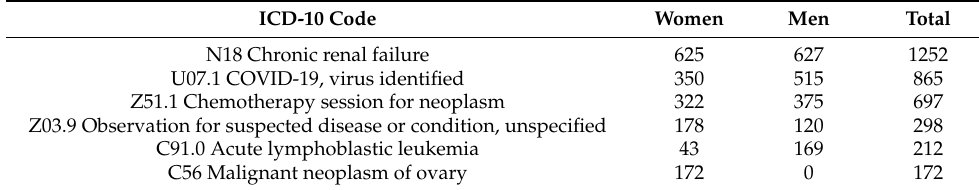
Table 3. The most popular diagnoses in the group of patients by